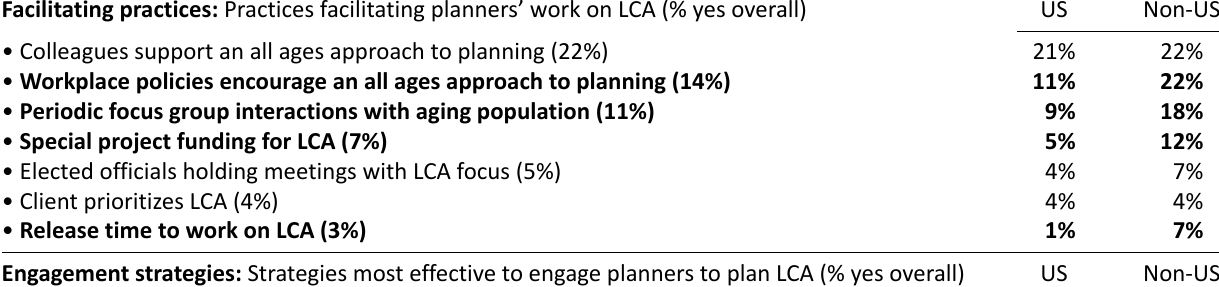
Table 4. Facilitating practices and engagement strategies. Source: International Planner Engagement Survey (AARP, 2017). Facilitating practices: Practices facilitating planners’ work on LCA (% yes